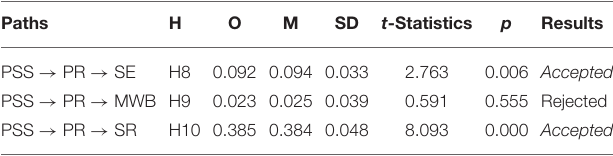
TABLE 6 | Indirect effects of the variable. Paths H O M SD t -Statistics p